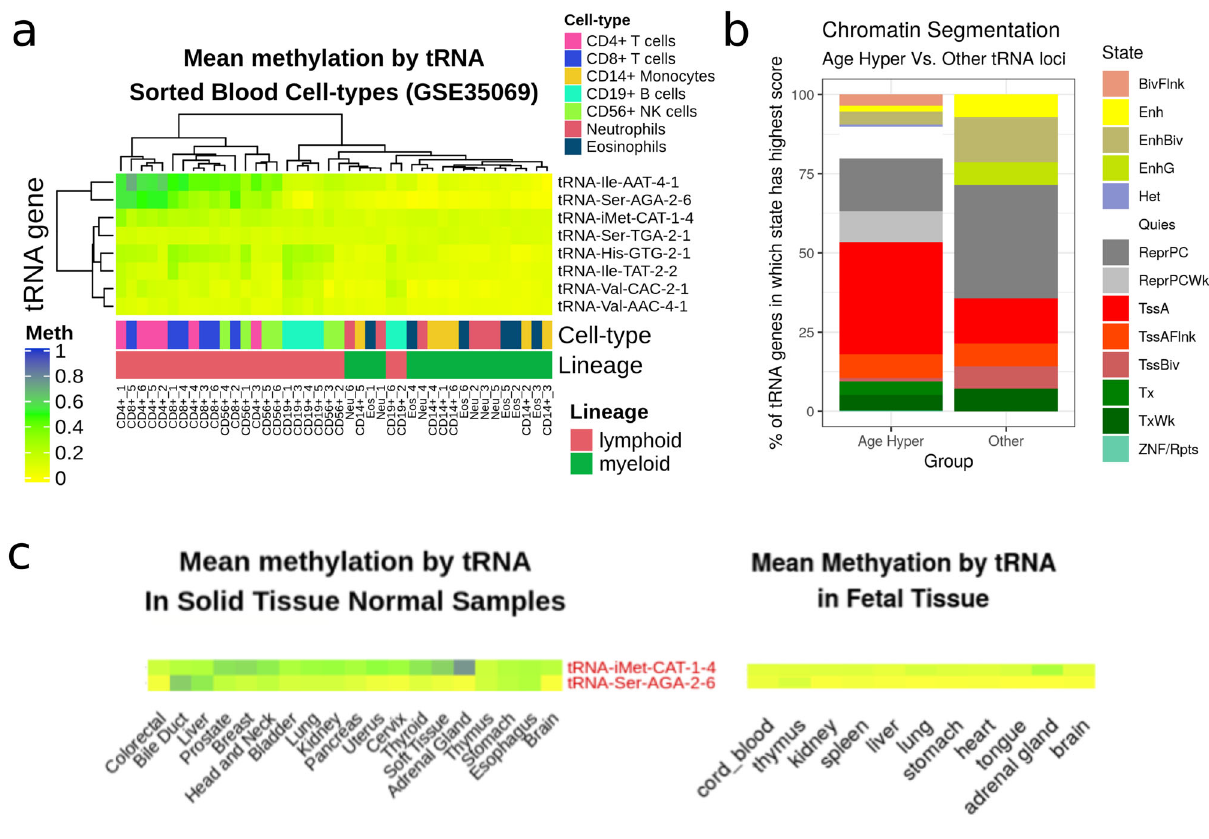
Fig. 7 tRNA gene DNA methylation in different blood cell types. a Heatmap of mean DNA methylation of tRNA sorted Blood Cell Types (data from Reinus et al., probes covering 8 of the 16 study-wide signi fi cant tRNA in 7 cell-type fractions from 6 males via GSE35069, 57,118 ). This illustrates the ability of tRNA gene methylation to separate the myeloid from the lymphoid lineage and the higher methylation in the lymphoid lineage of the 3 cell-type corrected genome- wide signi fi cant tRNAs (iMet-CAT-1-4, etc.) b Chromatin segmentation data for ‘ Blood & T-cell ’ from Epilogos 15 State model 52,53 . Proportion represents the frequency of the predominant chromatin state at a given tRNA (±200 bp) for 14/16 study-wide signi fi cant tRNAs covered compared to the other 371 available tRNAs. The ageing-related hypermethylated tRNAs are enriched for enhancer chromatin state (Fisher ’ s exact p = 0.01). c DNA methylation in 19 tissues from TCGA normal tissue samples and 11 foetal tissues for iMet-CAT-1-4 and Ser-AGA-2-6 (Colour scale as in panel ( a )). Source data are provided as a Source Data fi